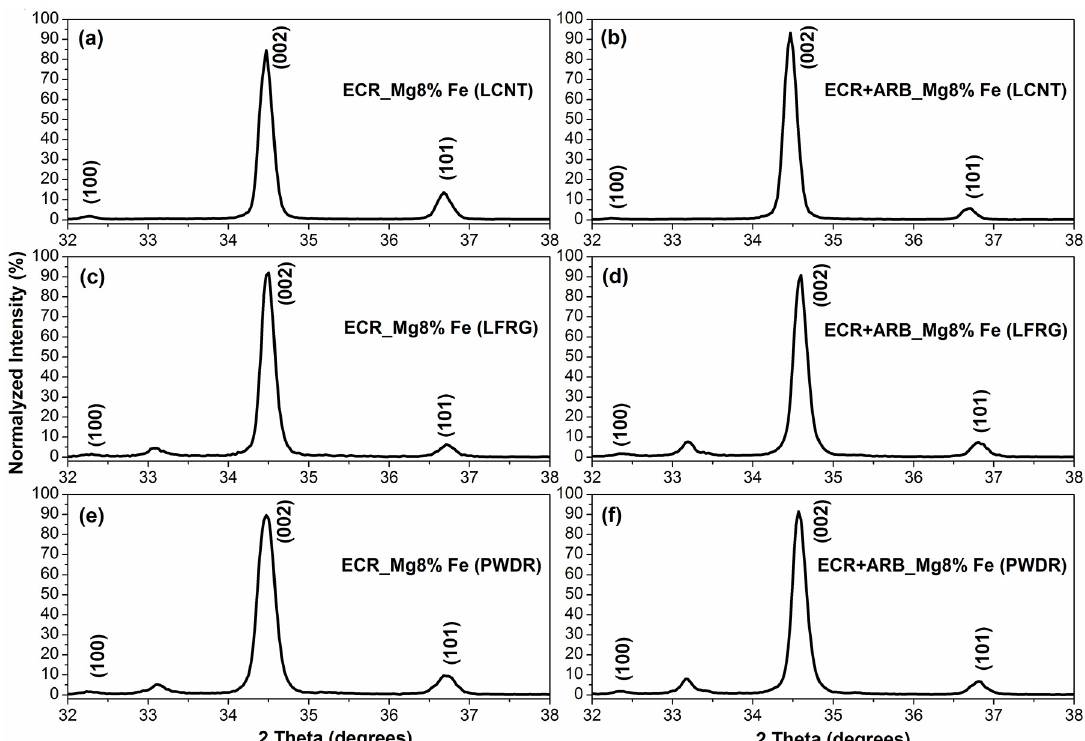
Figure 1. XRD patterns of longitudinal section of Mg-8 mol% Fe samples, comparing samples processed by ECR (left hand side) and by ECR+ARB (right hand side) with the folowing morphologies for Fe: (a,b) LCNT, (c,d) LFRG and (e,f)